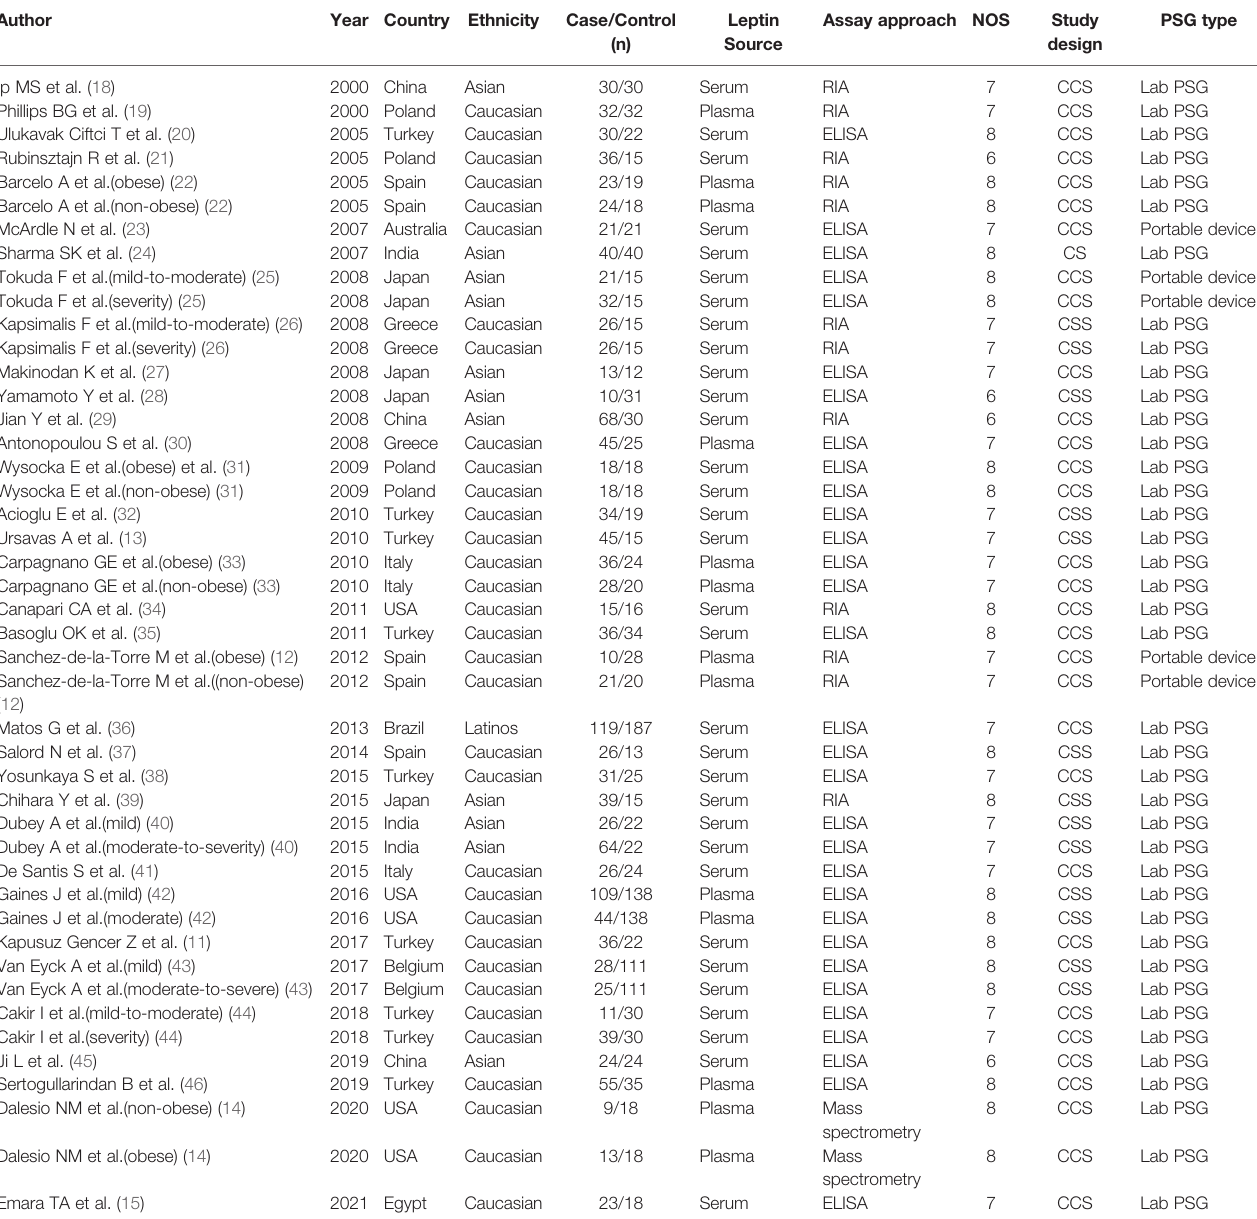
TABLE 1 | Characteristics of included